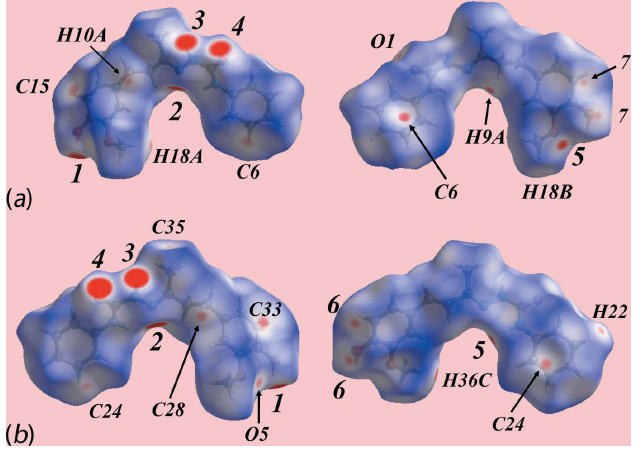
Figure 4 Views of the Hirshfeld surface for (I) mapped over d norm in the ranges ( a ) (cid:4) 0.150 to +1.462 au for the O1-containing molecule and ( b ) (cid:4) 0.215 to + 1.462 au for the O4-molecule.